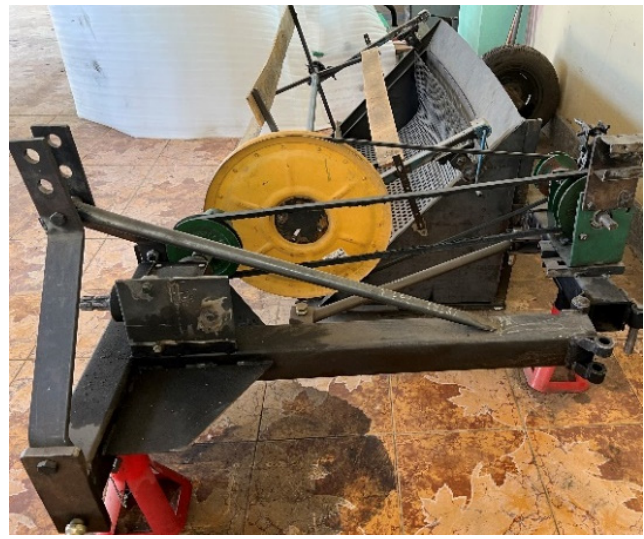
Figure 7 . The prototype chickpea harvester model 2021. Figure 7. The prototype chickpea harvester model